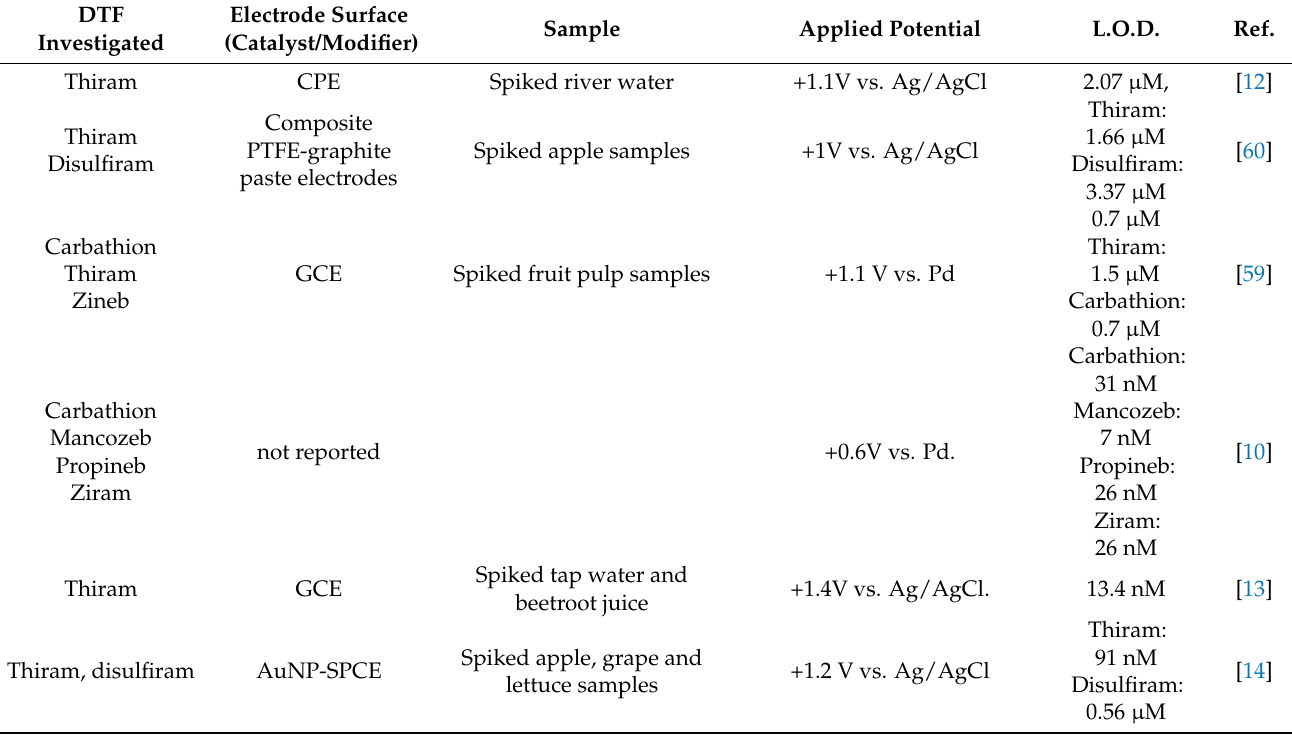
Table 2. Chromatography-coupled detection: selectivity via chromatographic separation of sample